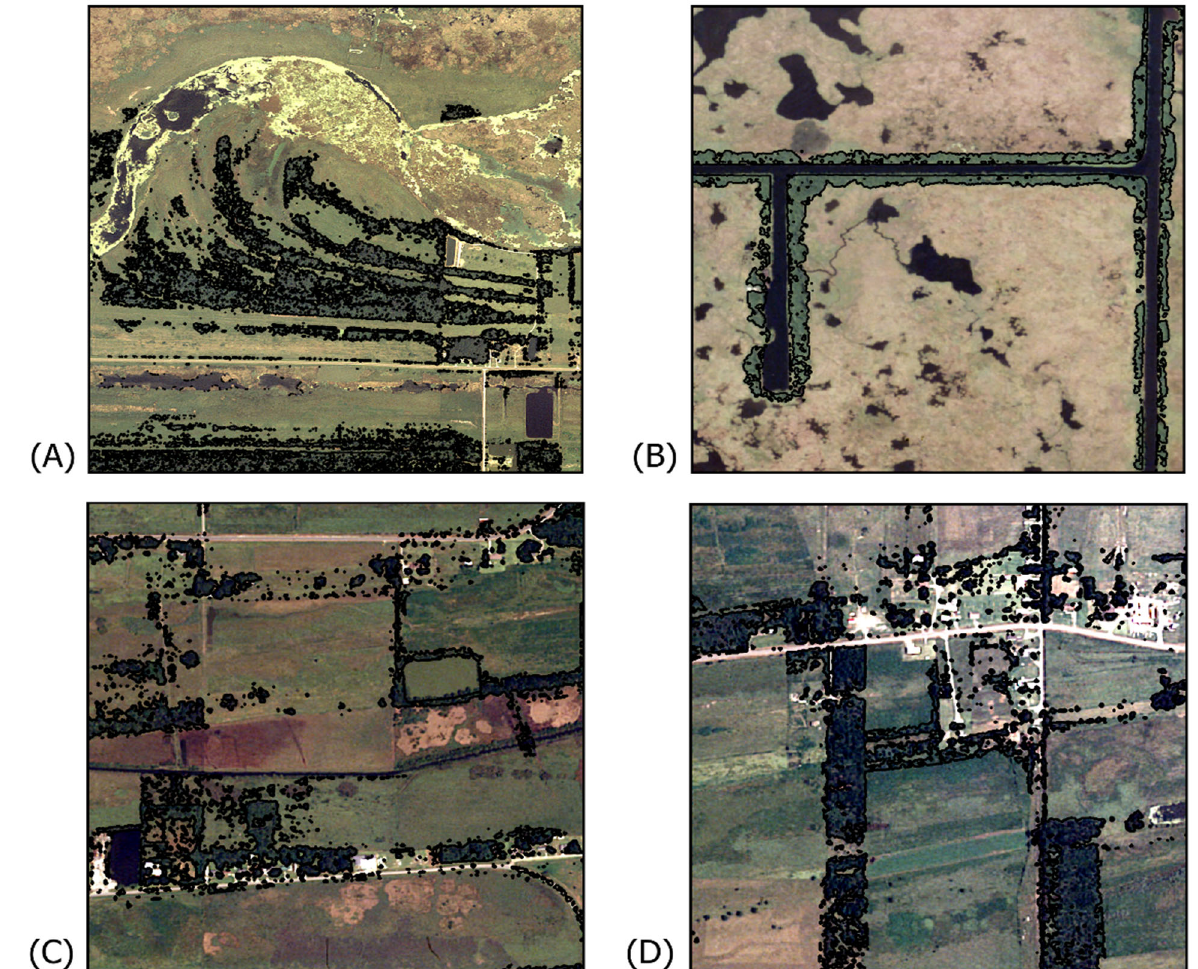
Figure 2. Panels ( A – D ) show diagnostic types of chenier forests. Panels ( A , C ) show a chenier remnant forest. Panel ( B ) is a spoil-bank forest from the days of oil exploration. The southern terminus of ( D ) shows a swamp forest which could inhabit less haline marsh communities found in the northern reaches of the Chenier Plains. The black-outlined areas are the respective years’ forest extent.